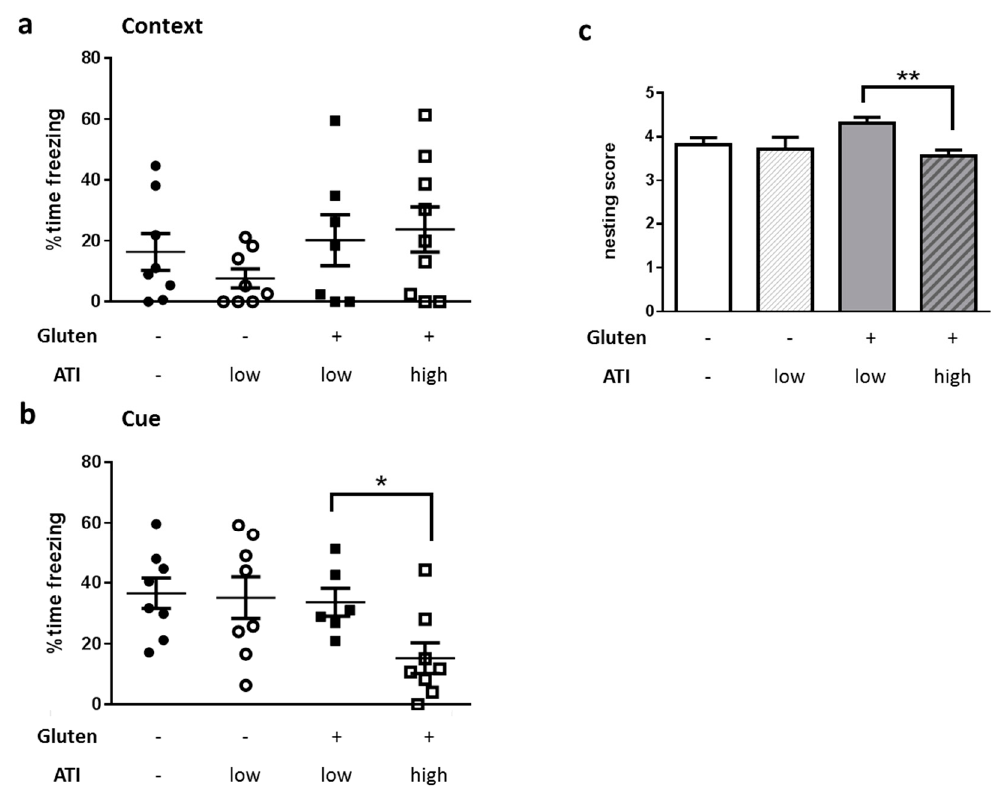
Figure 5. Influence of the quantity of ATI supplied in the diets on hippocampus-dependent tasks in 5xFAD mice. Mice were subjected to fear conditioning learning and memory recall in a context ( a )- or cue ( b )-dependent manner. ( c ) Nesting score. Mice were habituated to a special nesting material and nests were scored after overnight construction. All data are presented as mean with SEM. Statistical